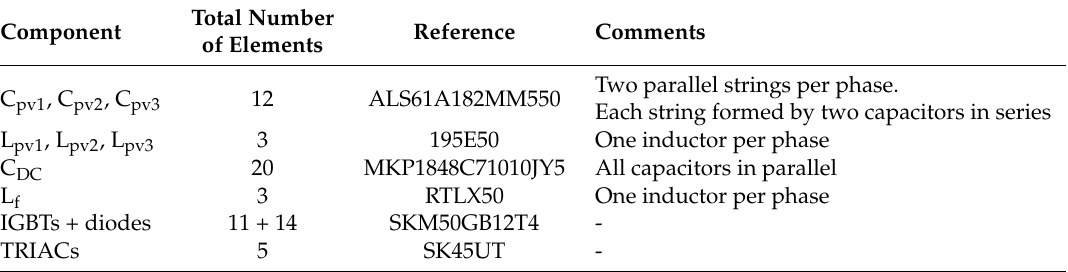
Table 1. References and number of elements of the selected components.